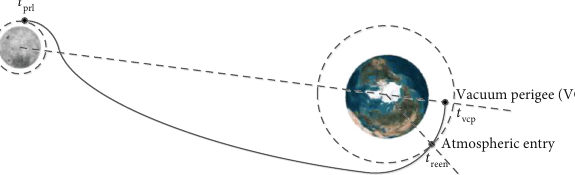
Figure 3: Moon-to-Earth trajectory and vacuum